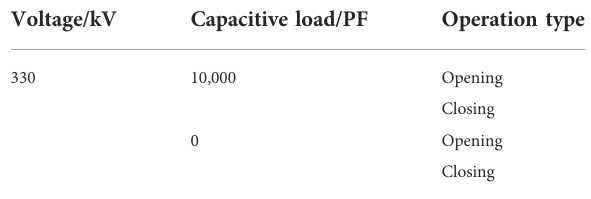
TABLE 1 Test measurement plan.